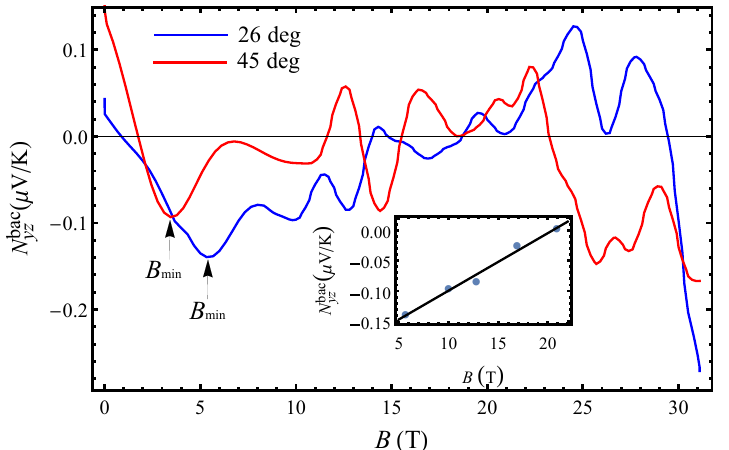
Figure 6. Magnetic field dependence of the background Nernst effect in α - ( BEDT-TTF ) 2 KHg ( SCN ) 4 , N bac yz ( B ) after filtering out the quantum oscillation component. The minimum and maximum features that appear in the field dependence at different field orientations are evident. The arrows indicate B min , which is angle-dependent and decreases with the increasing tilt angle. The inset shows the magnetic field dependence of the dip-to-dip amplitude of the Nernst effect at θ max1 = 26 ◦